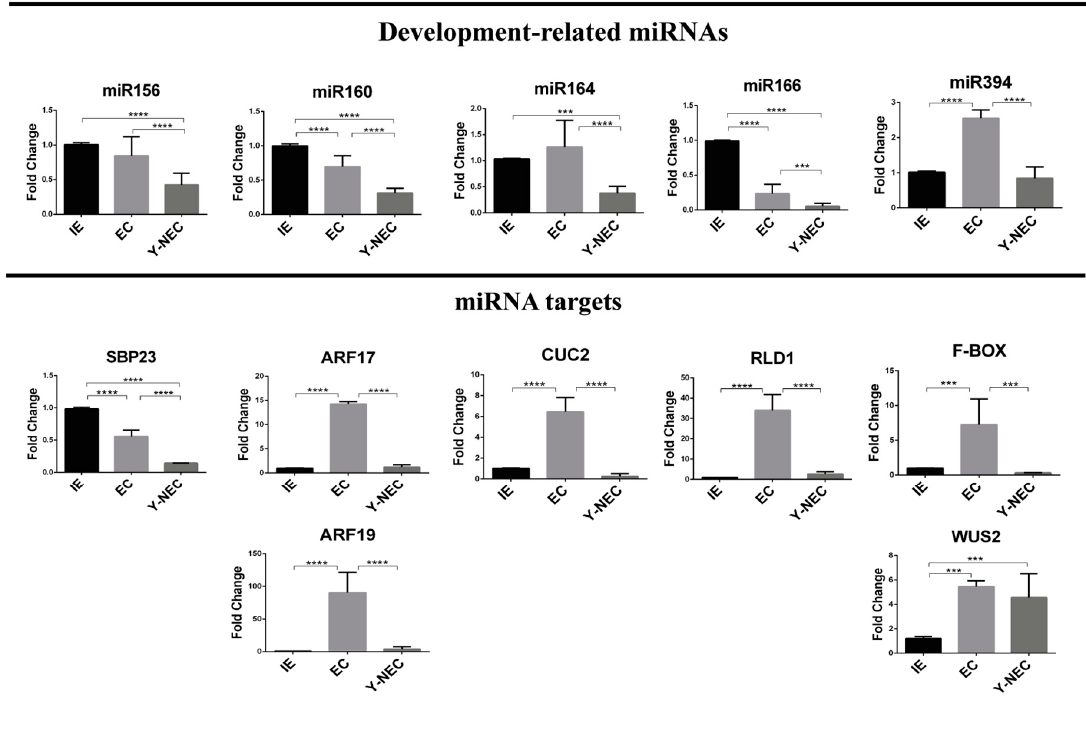
Figure 4. Development-related miRNAs and their target abundances in maize VS-535 SE. miRNA and mRNA abundances were analyzed by qRT-PCR in Tuxpeño VS-535 immature embryos (IE) used as explants to induce SE, and in established 12 month-old embryogenic (EC) and non-embryogenic (Y-NEC) callus tissues. Each miRNA target is shown below the corresponding miRNA, except for WUS2, which is not a direct target of miR394, but is instead regulated by an F-Box protein target of miR394. Fold change represents abundance relative to the IE and normalized by U6 snRNA internal control. Significant values are indicated as follows: (***) p < 0.001, (****) p < 0.0001.